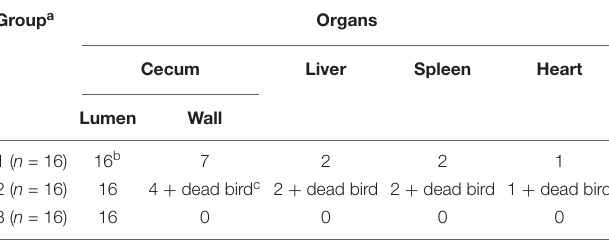
TABLE 3 | Detection of E. coli with immunohistochemistry in